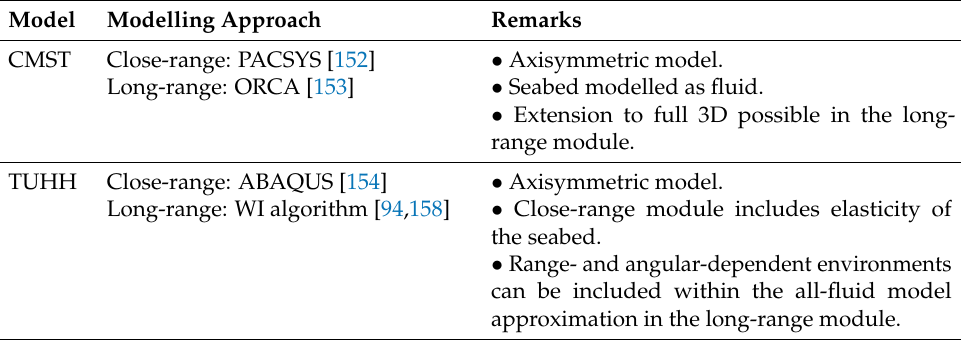
Table 1. List of available models to predict noise by impact